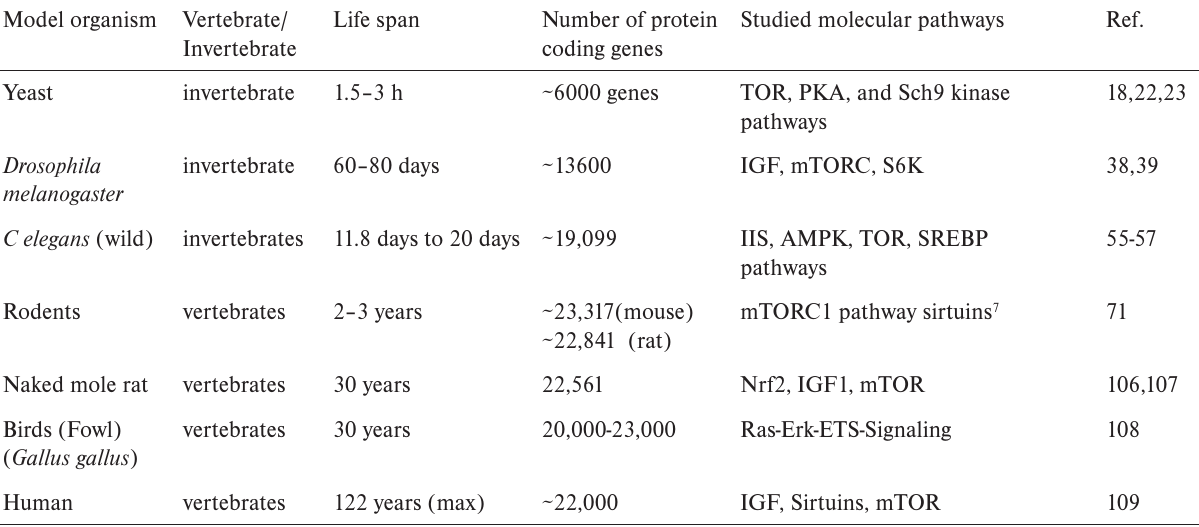
Table 1. Lifespan and coding genes in aging model organisms: Comparison with human. Model